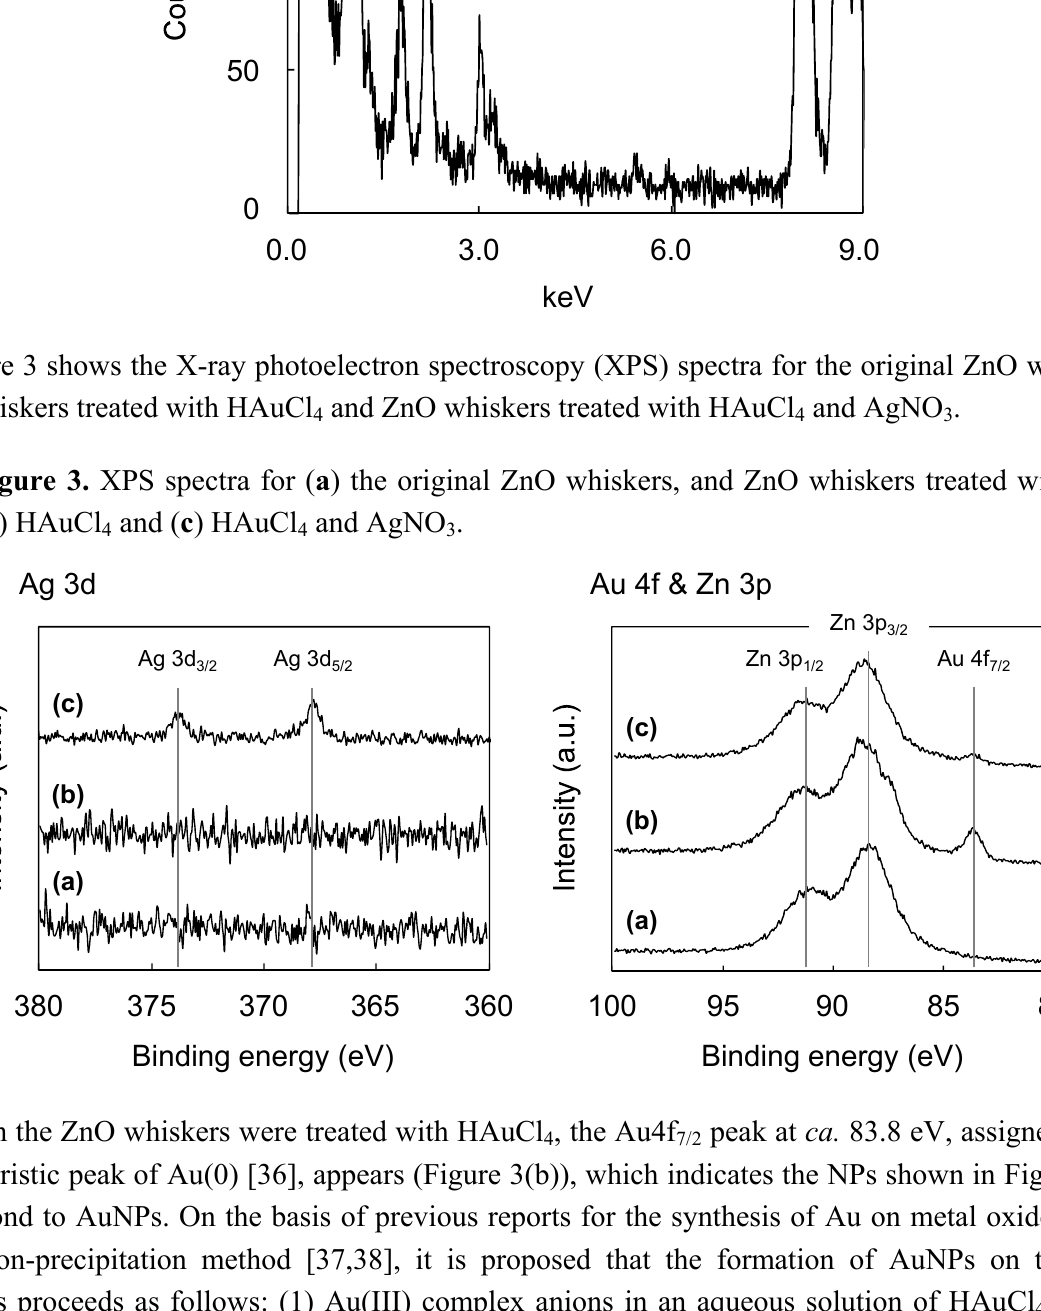
Figure 2. EDS spectrum of NPs on ZnO whiskers treated with HAuCl